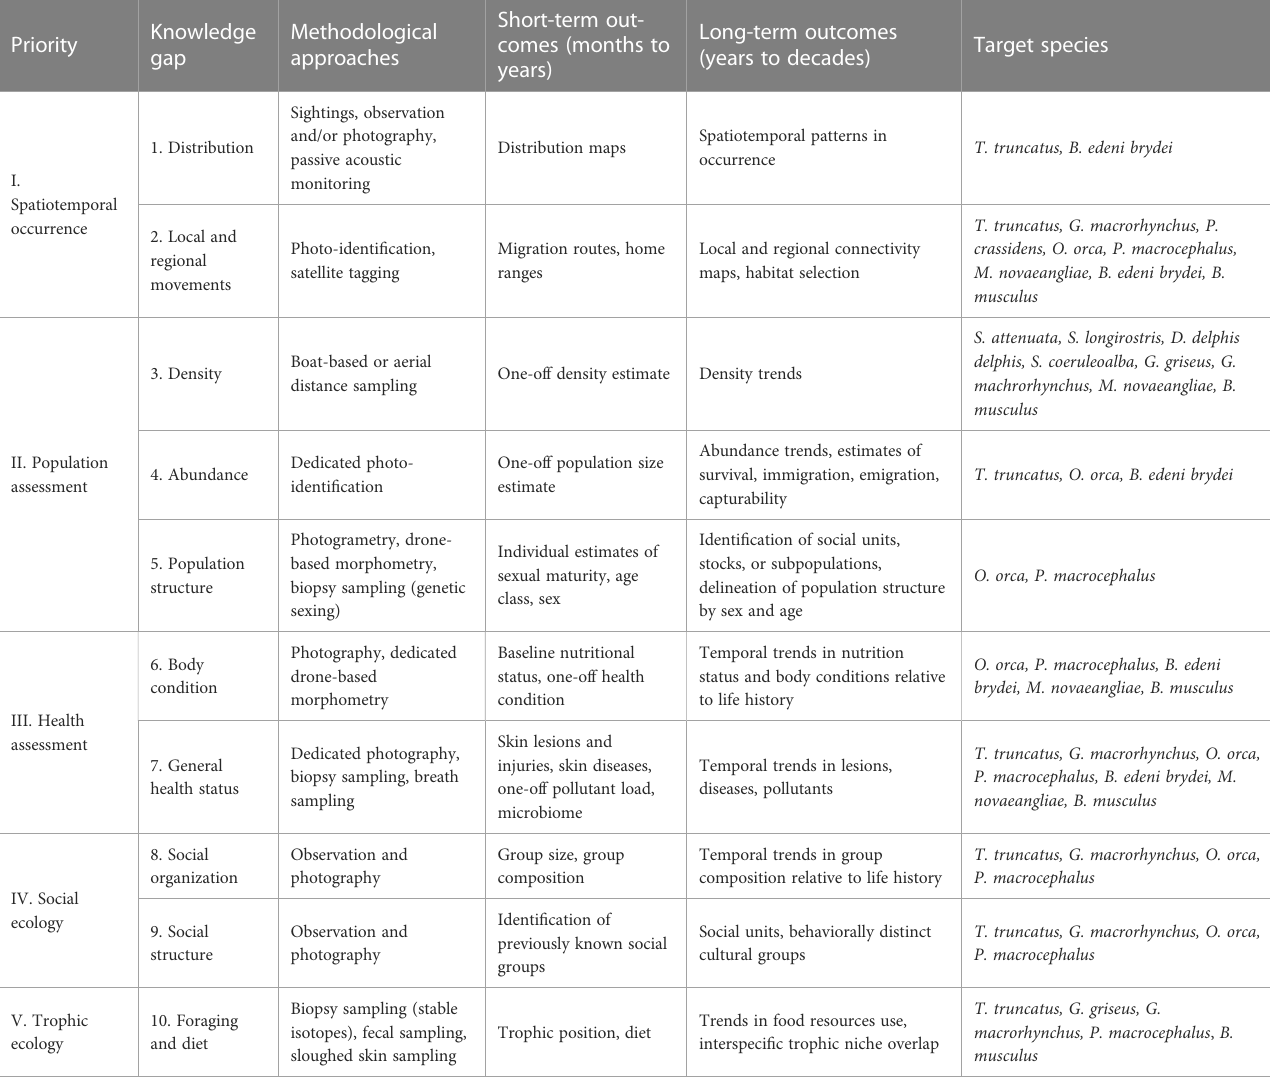
TABLE 2 Summary of the proposed priorities for ecological research on cetaceans in Gala ́ pagos, along with knowledge gaps, suggested methodological approaches, expected outcomes in the short- (months to years) and long-term (years to decades), and species that are best suited for these